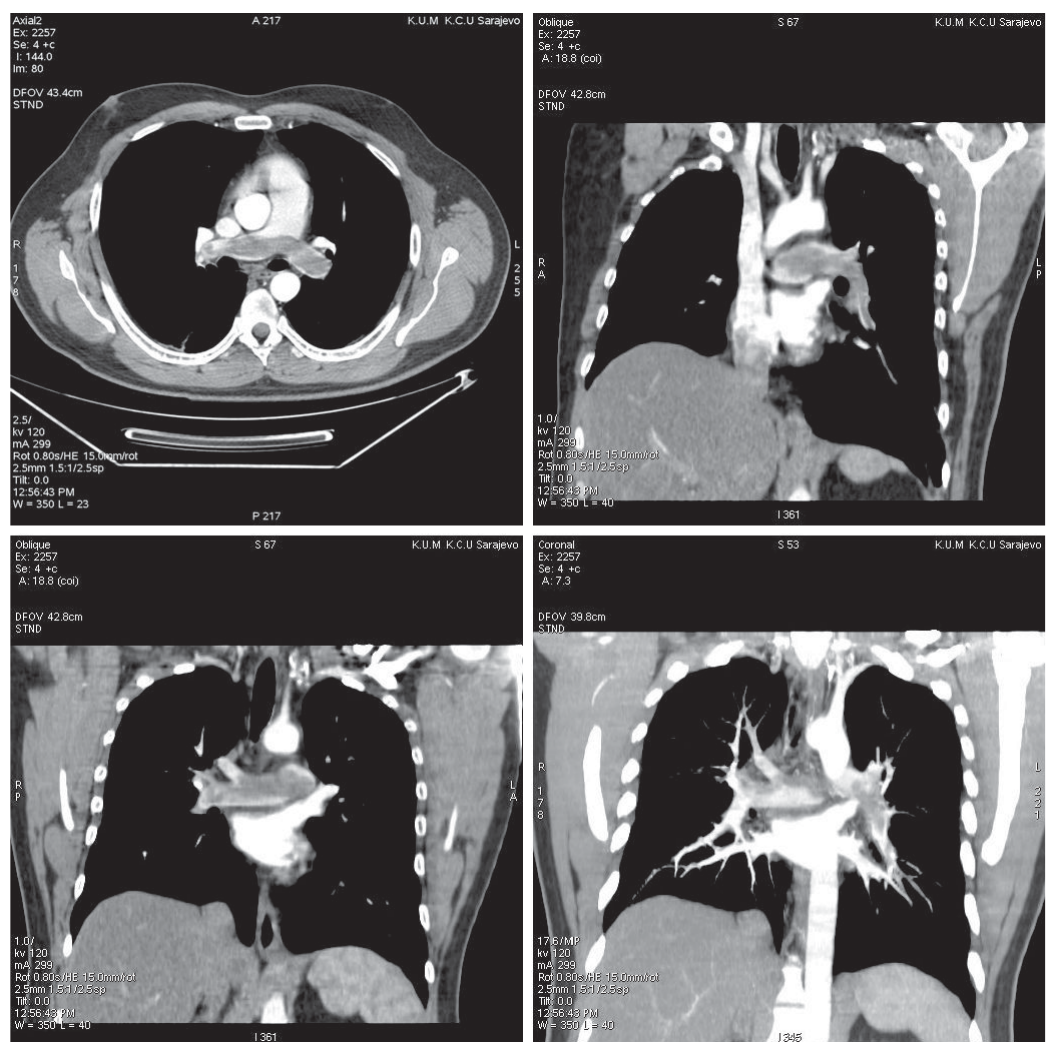
FIGURE 3. Massive pulmonary embolism: thrombotic masses in both pulmonary